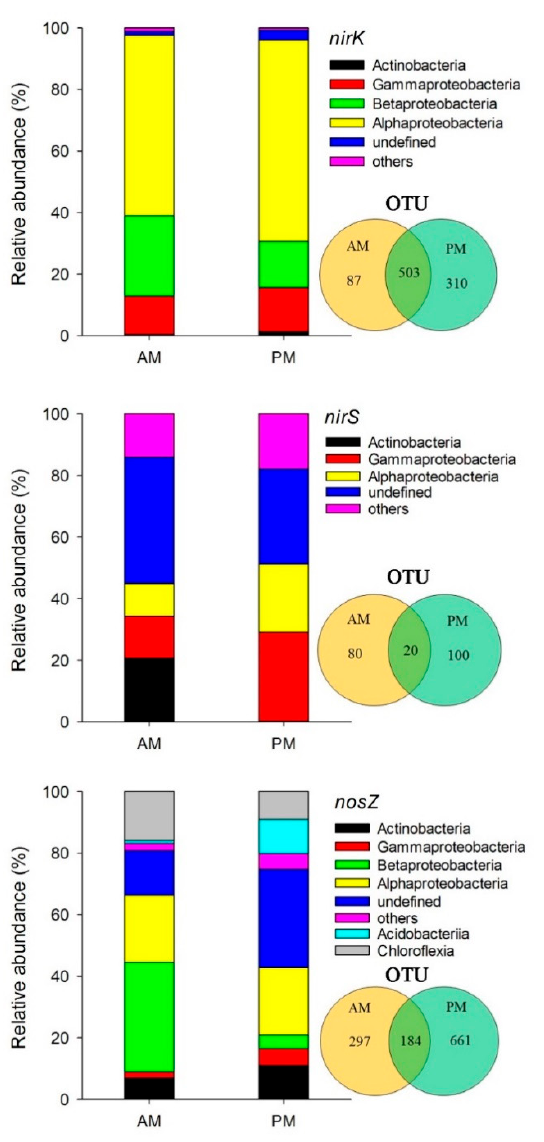
Figure 1. Composition of the nirK , nirS , and nosZ genes containing denitrifying bacterial communities in the Acacia mangium (AM) and Pinus massoniana (PM) plantations. The pie charts show the specific and shared Operational Taxonomic Units (OTUs) in the two types of plantations.